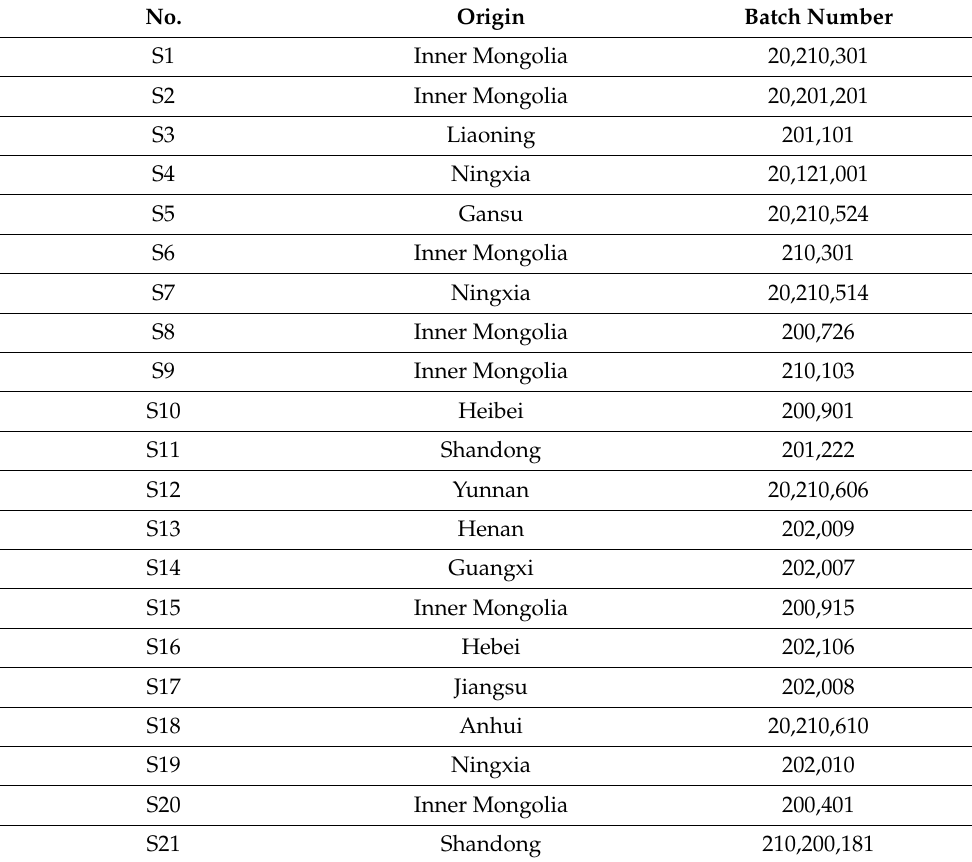
Table 1. Details of samples of Cuscutae